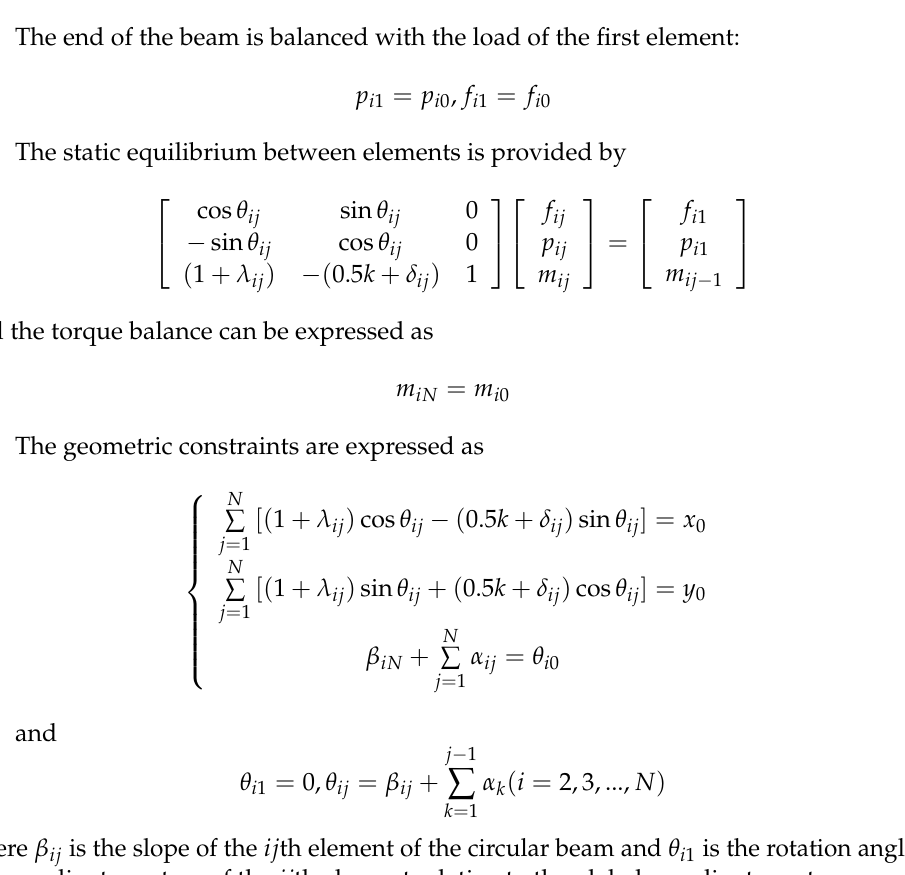
Figure 6. Element ij at its deflection